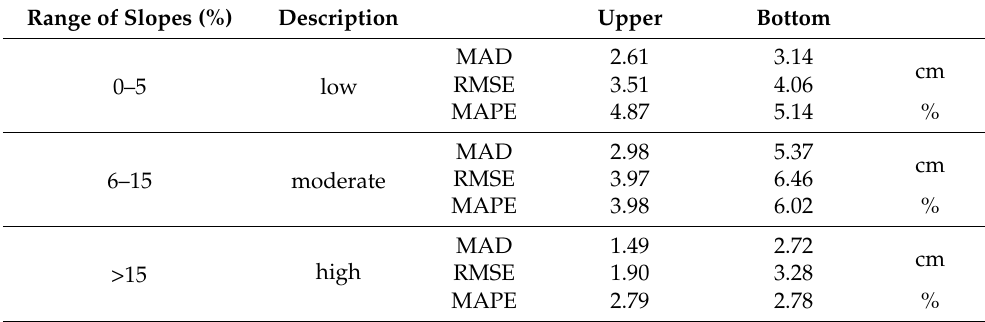
Table 2. Basic statistics of the three main categories according to the slope gradient in percentages of the linear regression analysis with their corresponding mean absolute deviation (MAD), root mean square error (RMSE), and mean average percentage error